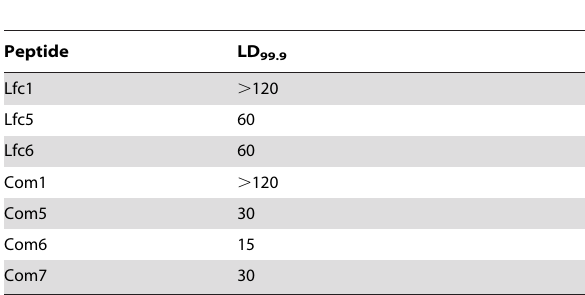
Table 4. Anti- S. aureus activities of selected peptides in 25% human